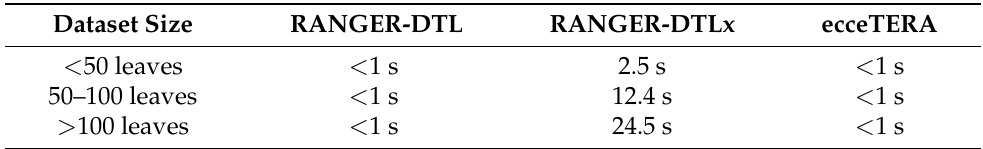
Table 7. Runtime comparison on the biological